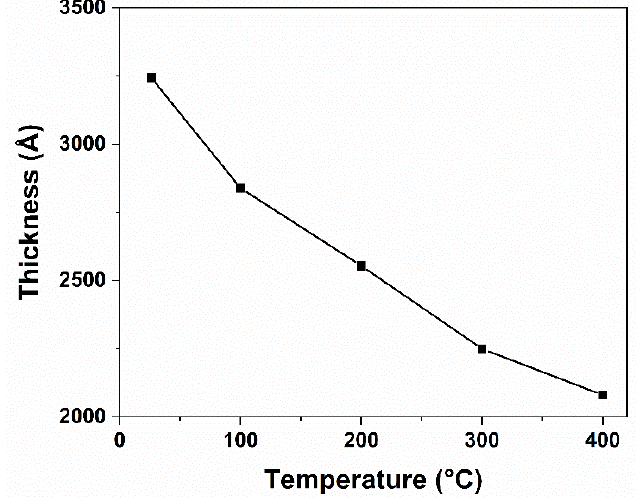
Figure 2. Thickness of CuInO x films at varying substrate temperatures after 5 min of sputtering process.